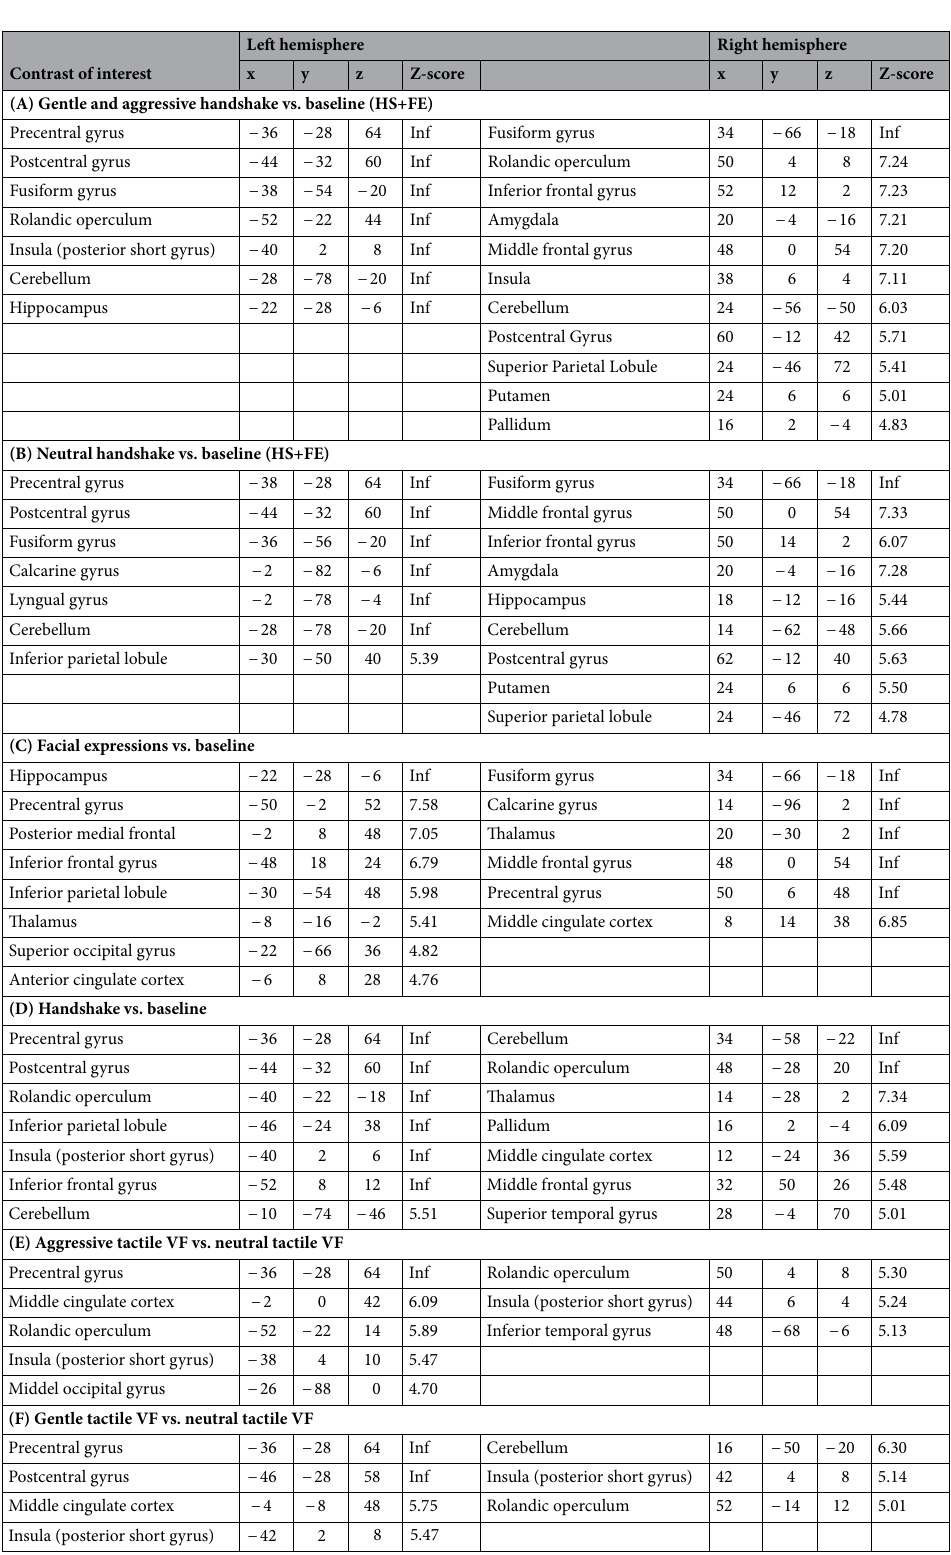
Table 1. Brain activations obtained in Exp. 1 from the three different situations (handshake and facial expression; facial expression; handshake). Activations obtained in the first situation (HS + FE) during the vitality forms (aggressive and gentle) (A) and neutral (B) (control) conditions vs. baseline. Activations obtained in the second (facial expression) (C) and third situations (handshake) (D) vs. baseline. Activation resulting from aggressive vs. neutral (E) and gentle vs. neutral (F) contrasts. Local maxima, as shown in Figs. 2 and 3, are given in MNI standard brain coordinates, significant threshold was set at P FWE <